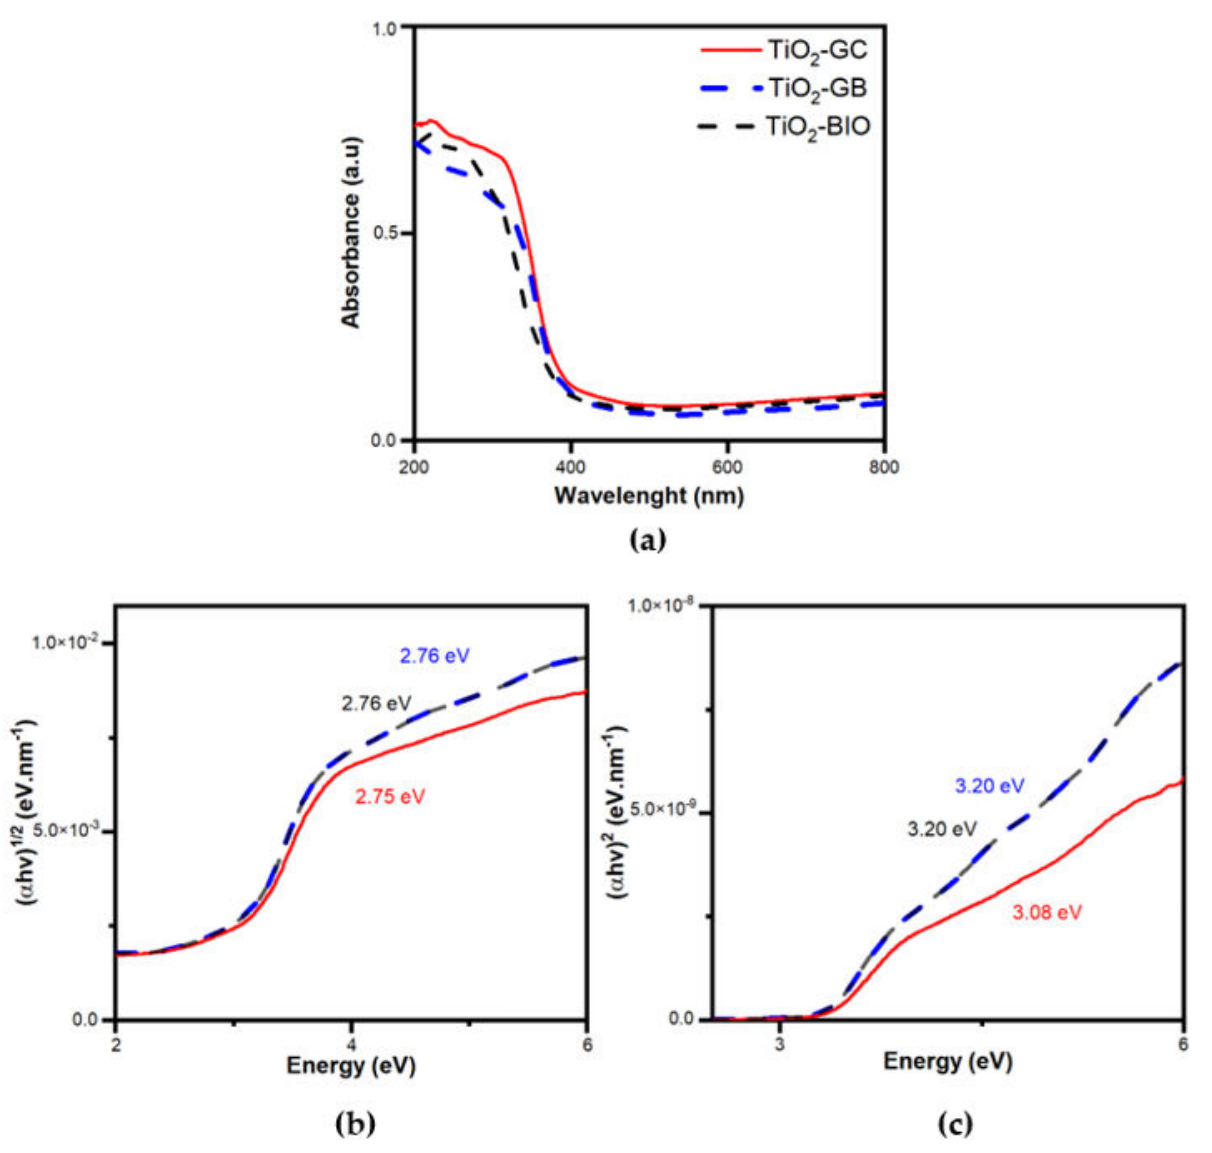
Figure 7. UV-visible spectroscopy data: ( a ) Absorption spectra of the three samples; ( b ) Tauc plot with an anatase band gap for the three samples; ( c ) Tauc plot with a rutile band gap for the three